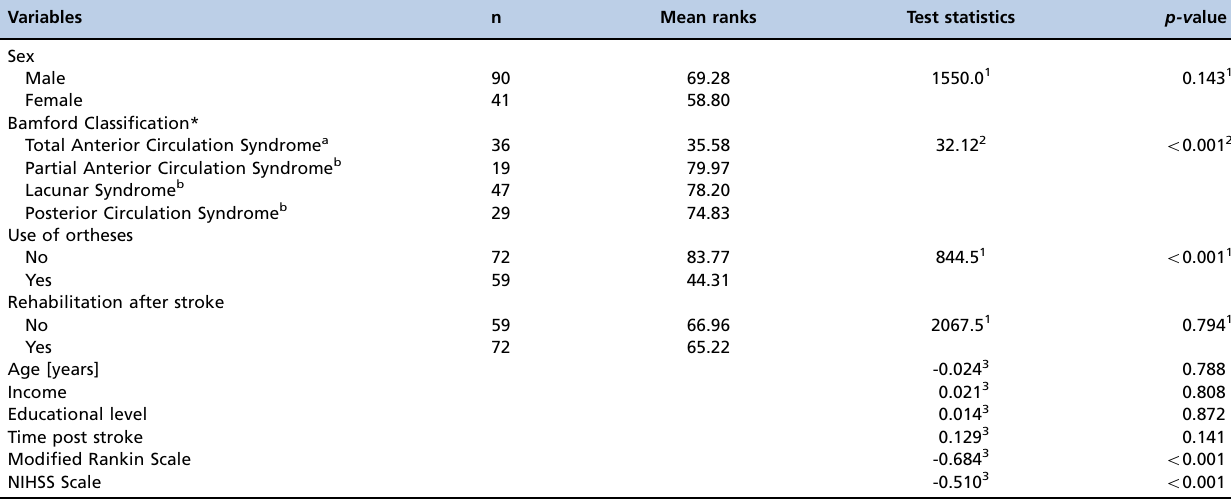
Table 3 - Association between the characteristics of patients with ischemic stroke and quality of life.